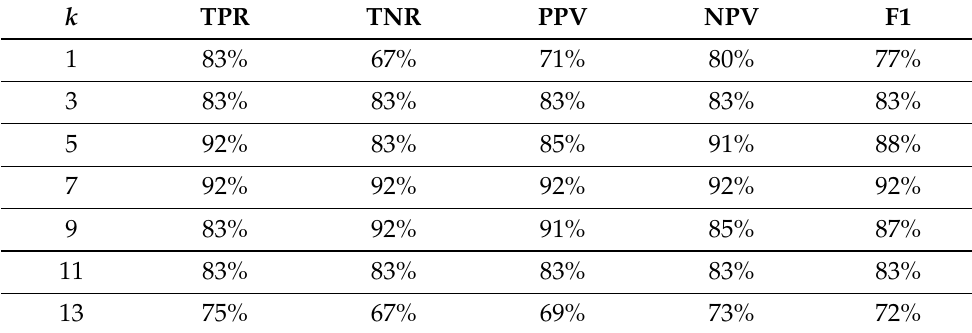
Table 3. Classic binary classification metrics for different values of parameter k